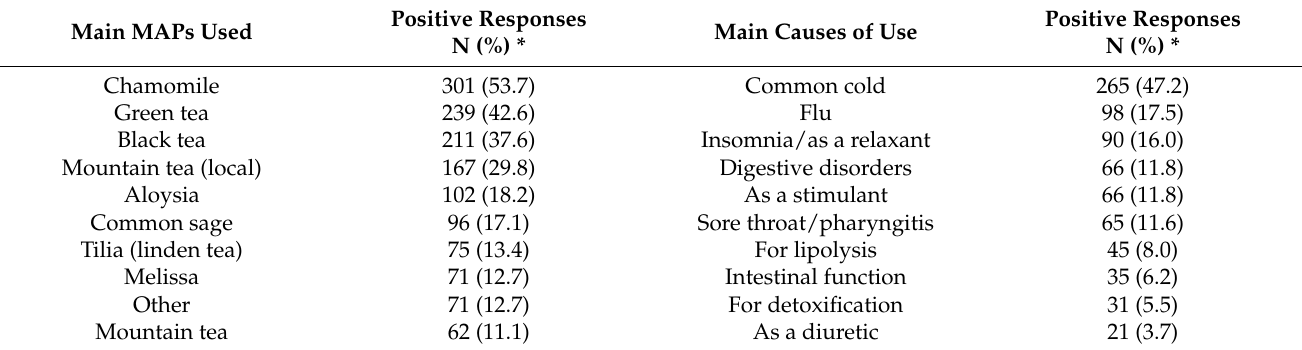
Table 3. Distribution of main MAPs used and causes of use.